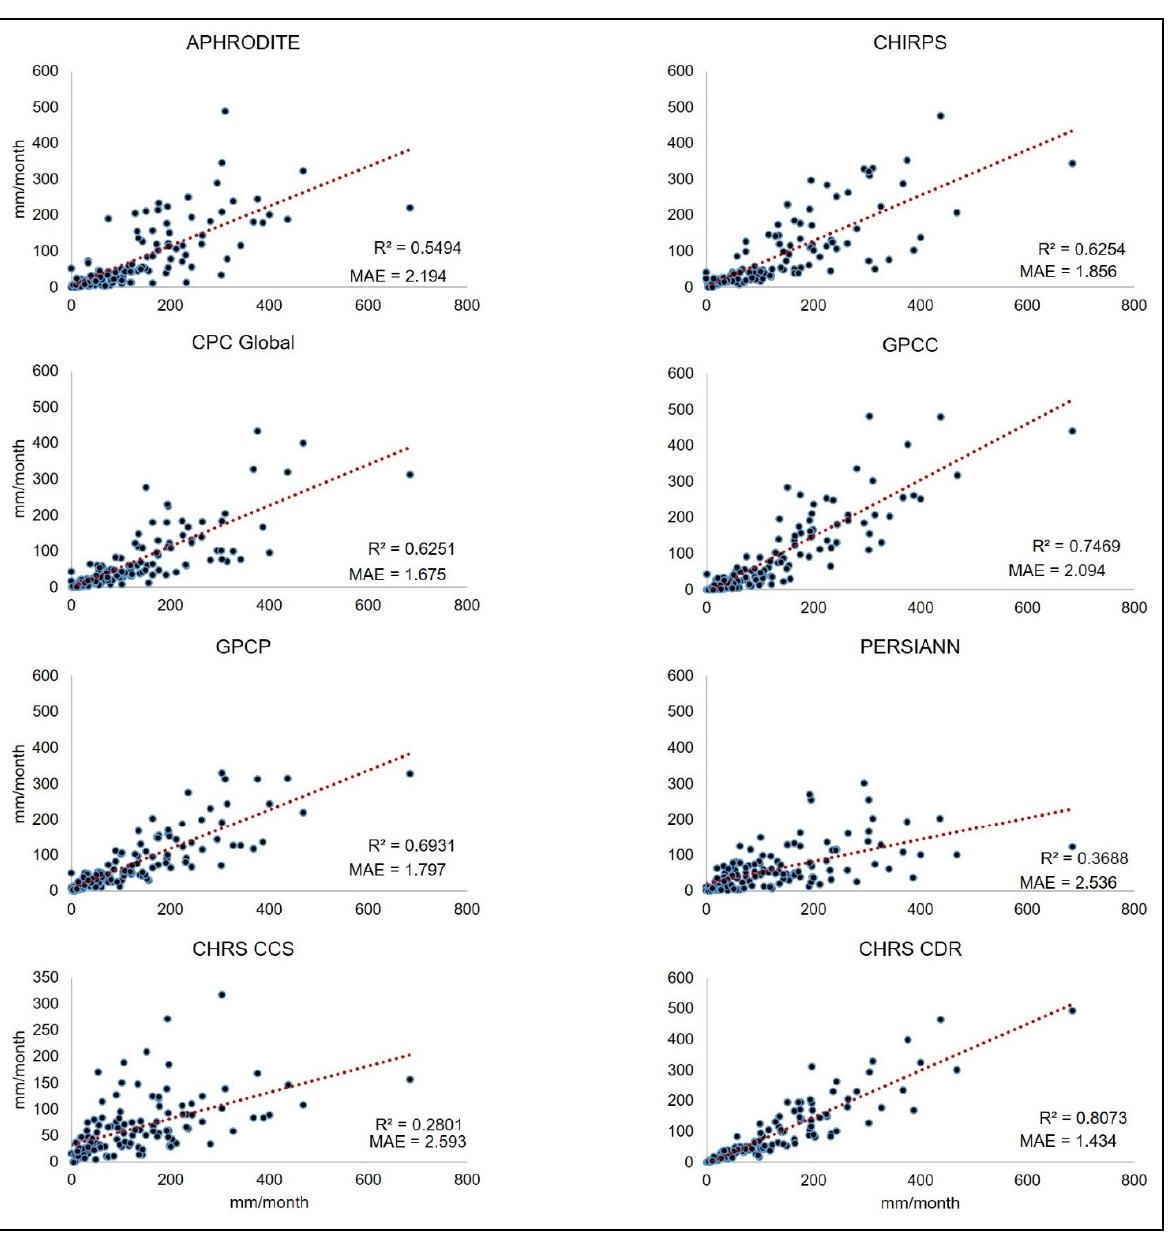
Figure 5. Performance of different PPs against gauged precipitation in simulating monthly precipi- tation in Chirah sub-catchment.